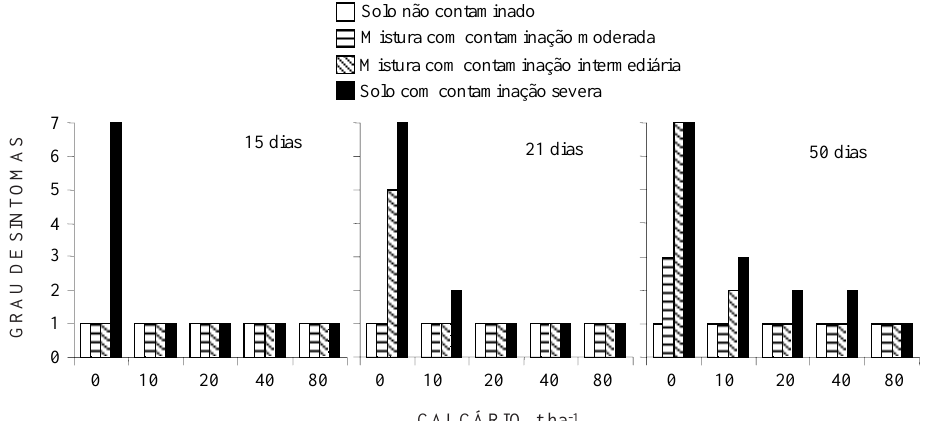
Figura 2. Graus de sintomas de toxidez de zinco e cádmio na parte aérea de mudas de Eucalyptus camaldulensis aos 15, 21 e 50 dias do transplantio para misturas de solos com diferentes níveis de contaminação com metais pesados e doses de calcário. Grau 1: ausência de sintoma de toxidez foliar; grau 2: clorose internerval e, ou, generalizada; grau 3: pontos e, ou, nervuras roxas, além dos sintomas descritos no grau 2; grau 4: manchas roxas, além dos sintomas descritos no grau 3; grau 5: encarquilhamento, além dos sintomas descritos no grau 4; grau 6: necrose, além dos sintomas descritos no grau 5; e grau 7: morte da